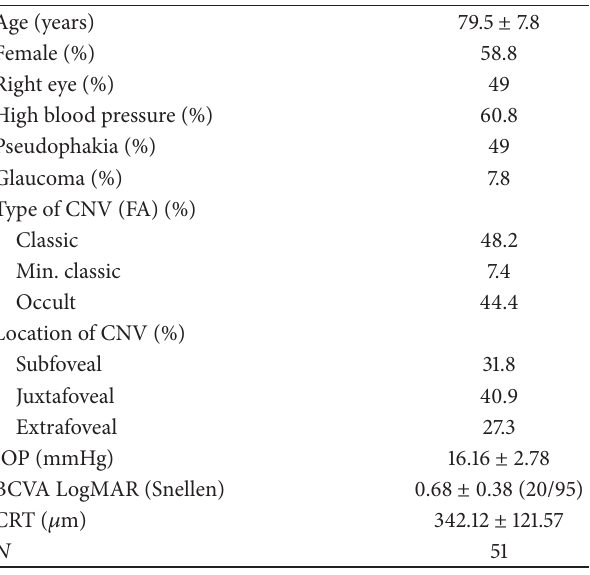
Table 1: Demographic and clinical characteristics of the sample.